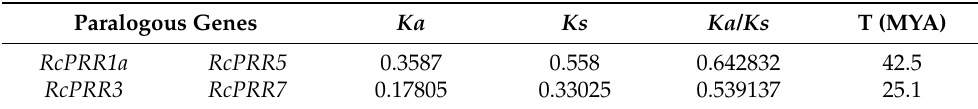
Table 1. Non-synonymous (Ka) and synonymous (Ks) substitution rate and divergence time of clock PRRs